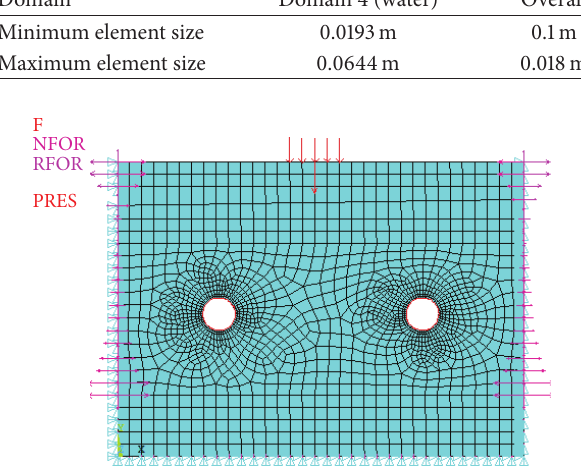
Figure 9: Load applied at the